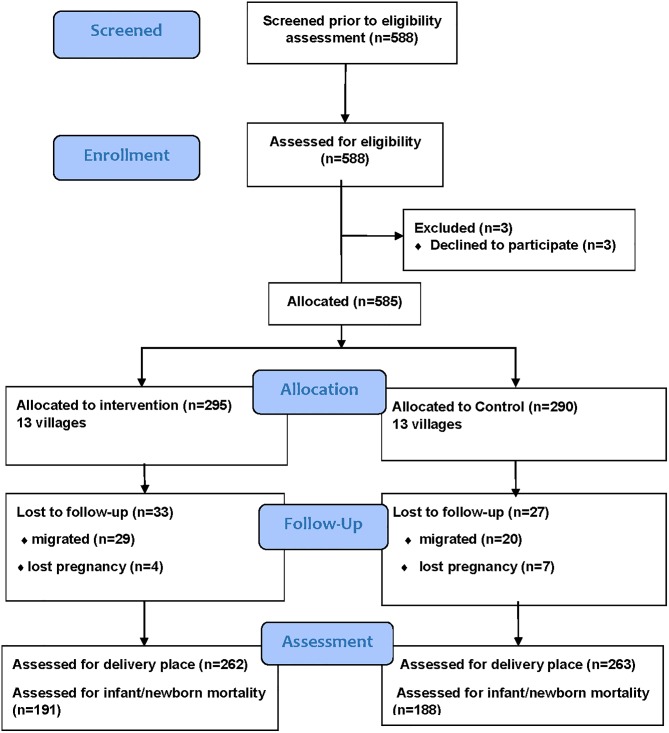
Flow chart showing enrolment and follow-up of pregnant women in rural Uganda.